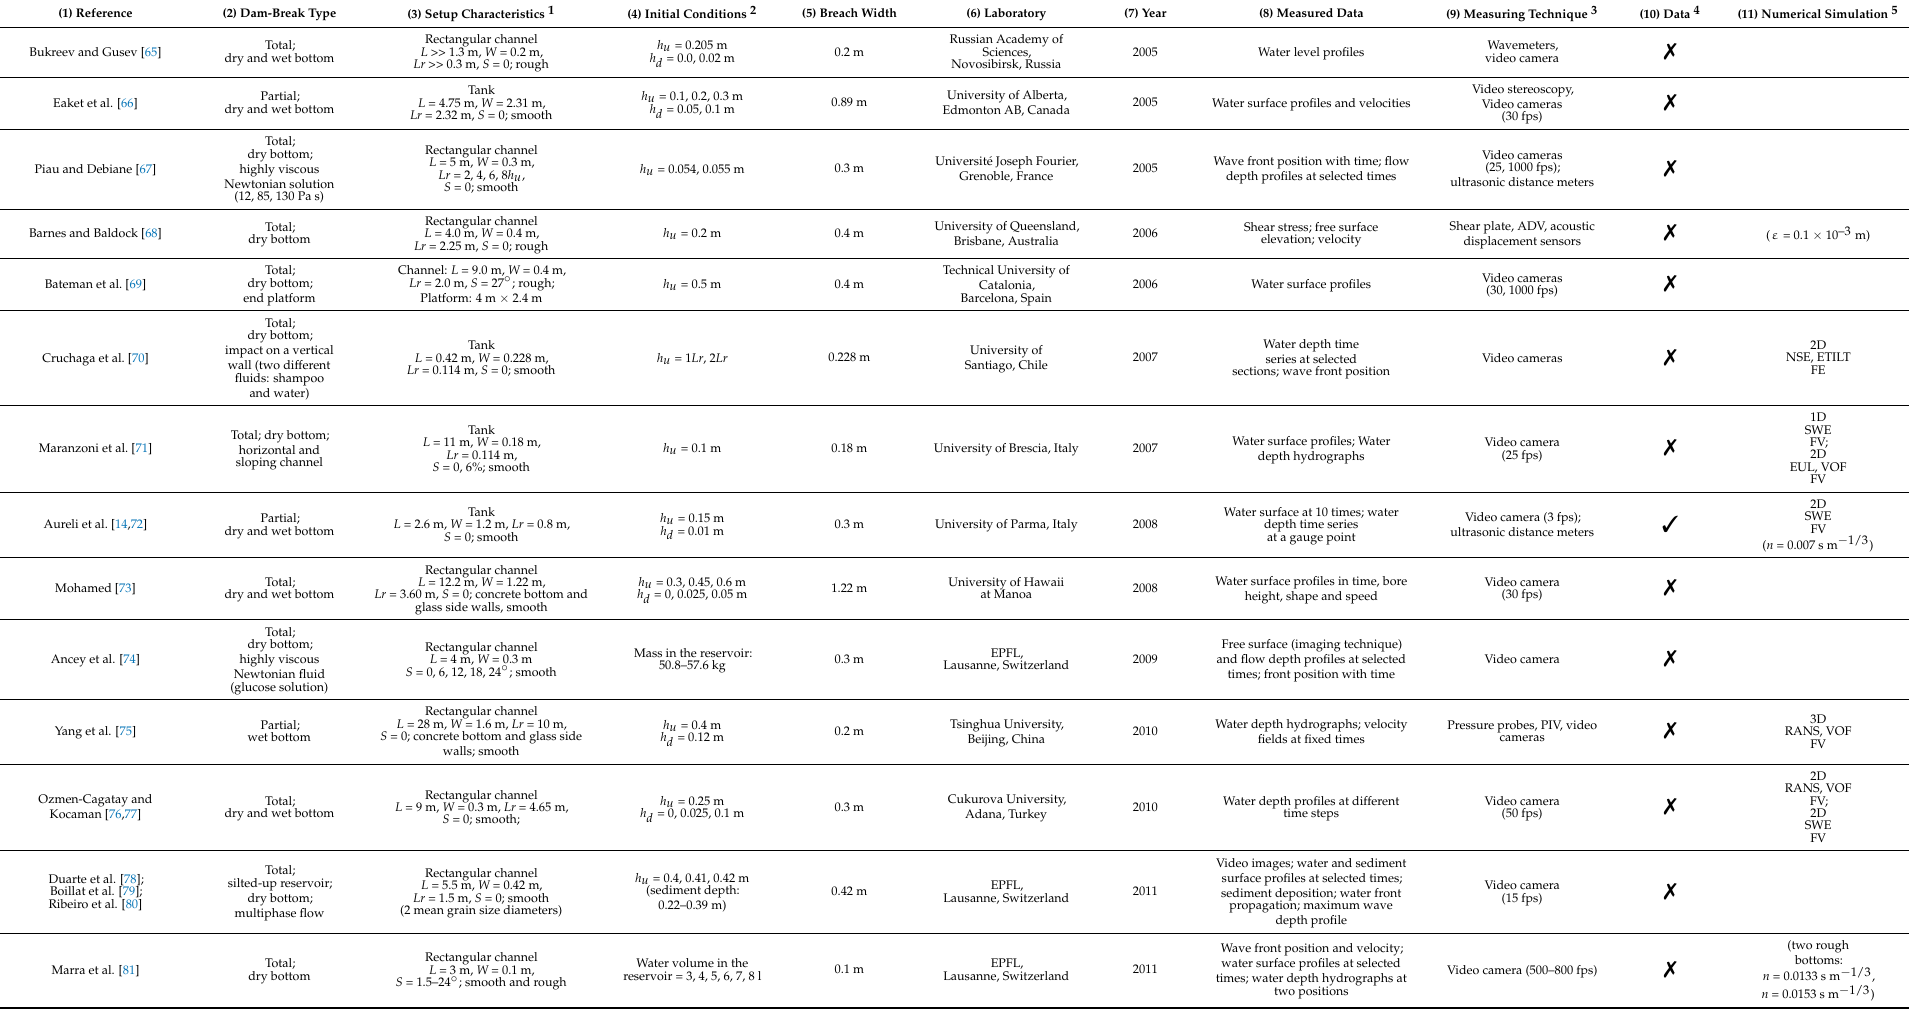
Table 1. Basic experimental investigations of fundamental dam-break wave physical characteristics.